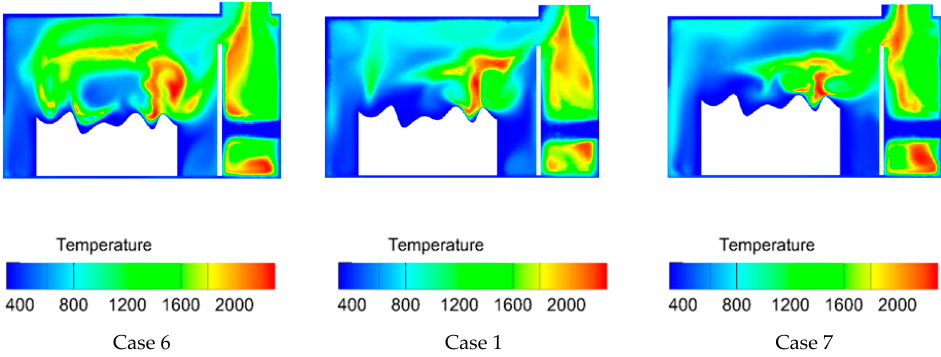
Figure 17. Temperature contours inside the incinerator for the variation of waste volume (K).